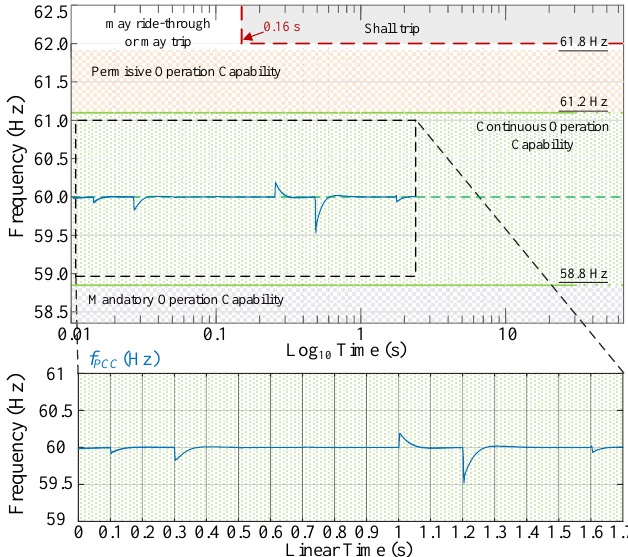
Figure 14. System response on frequency measured at the PCC.